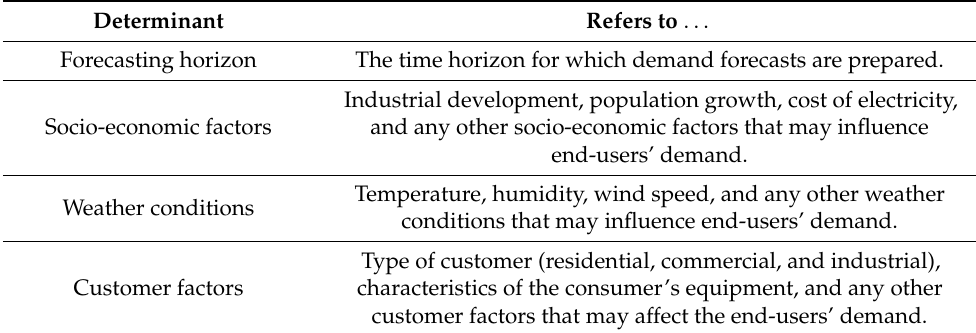
Table 2. Main variables affecting electricity